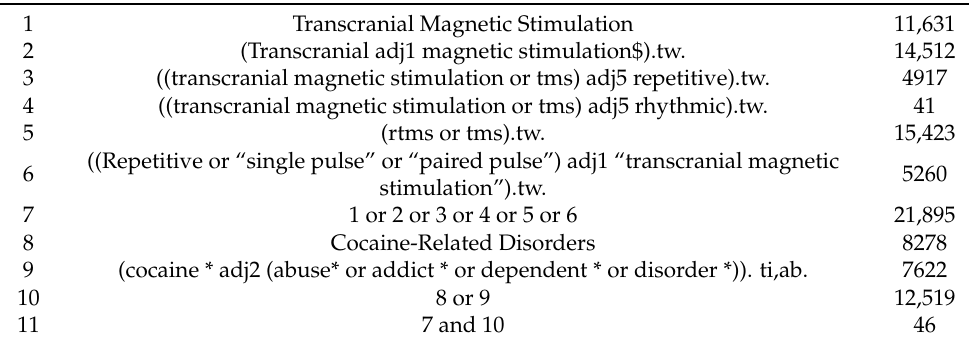
Table 1. Medline search